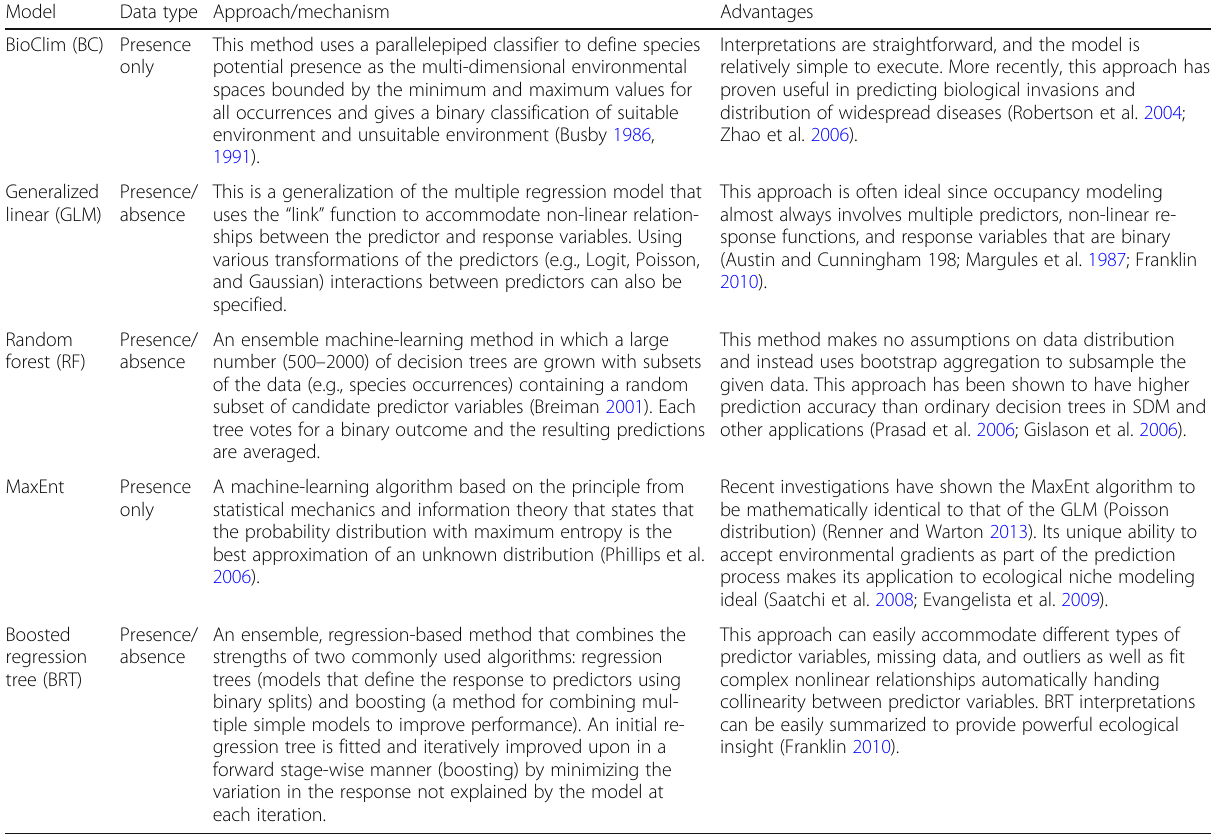
Table 2 Comparison of mathematical approach for each modeling algorithm being used to project species distributions in this study. Data requirements and advantages are also